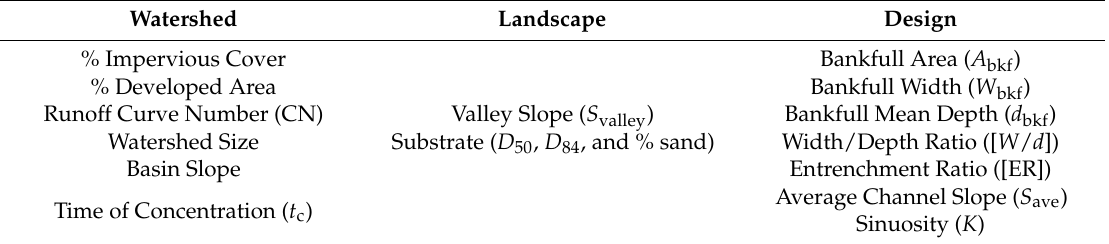
Table 1. Watershed, landscape, and design variables hypothesized to influence stream restoration performance and biologic outcome.